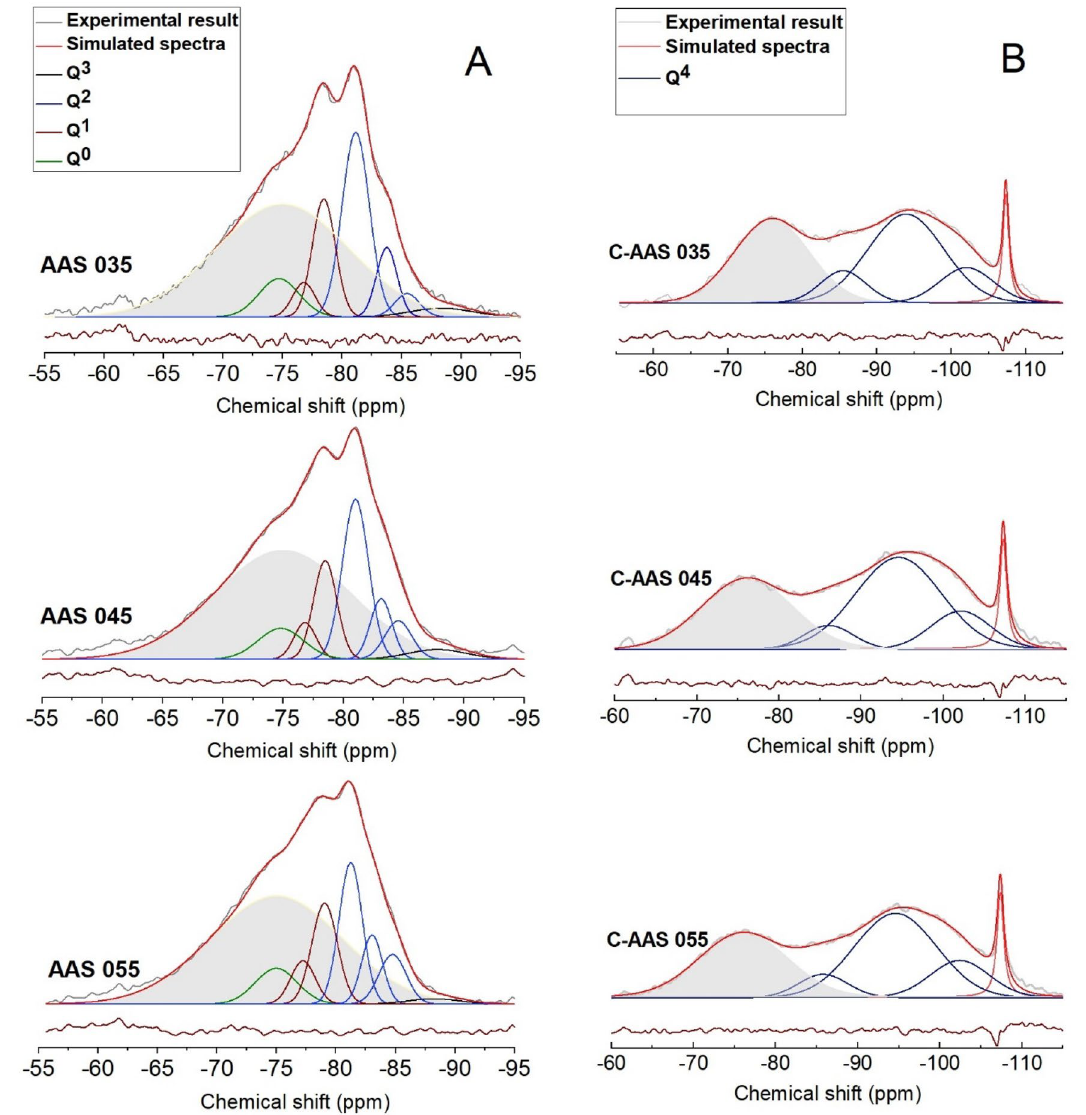
Figure 8. Deconvoluted 29 Si MAS NMR spectra of uncarbonated alkali activated slags at 28 days of curing (( A ) column), and carbonated alkali activated slag after 28 days of carbonation with 1% CO 2 and 60% RH (( B ) column) at different water to binder